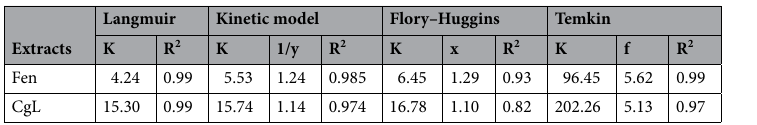
Table 4. Linear fitting parameters for the adsorption of Fen and CgL extracts on steel surface in 20% H 3 PO 4 at 30 °C.